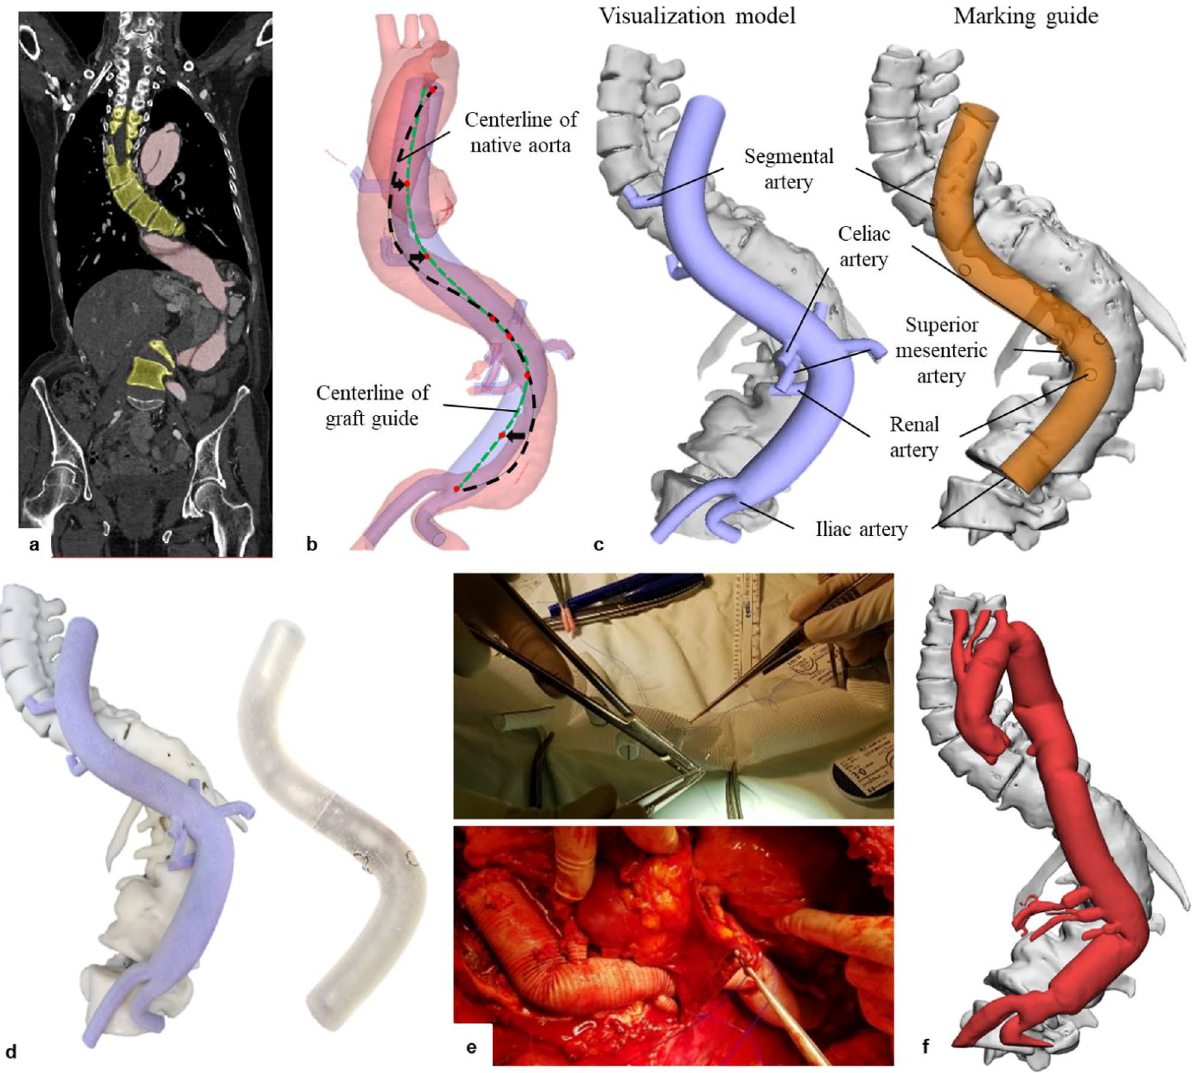
( b ) modelling the centreline of graft based on that of a native aorta; ( c ) 3D modelling of the visualization model and marking guide; ( d ) 3D-printed visualization model and marking guide; ( e ) graft reconstruction and clinical application in operating room; ( f ) postoperative